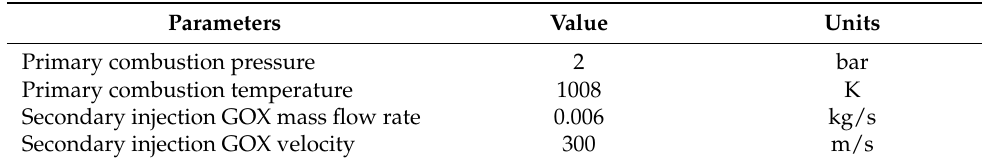
Table 10. Boundary conditions of the test.